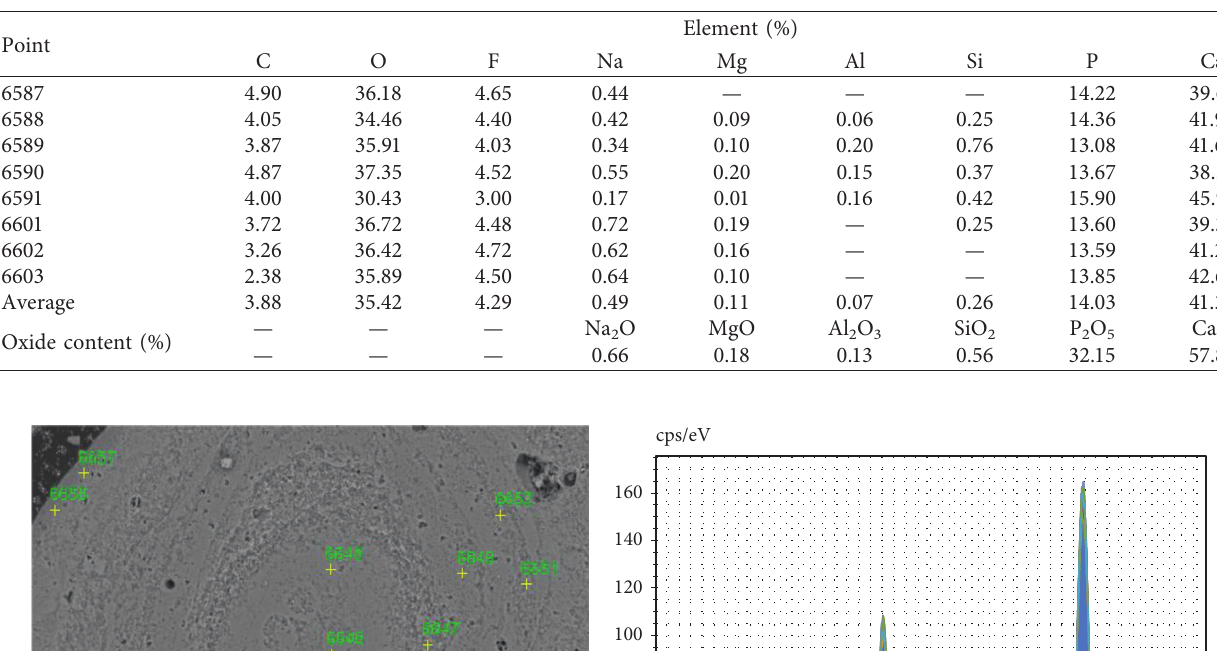
Table 3: Results of energy spectrum analysis of collophane.